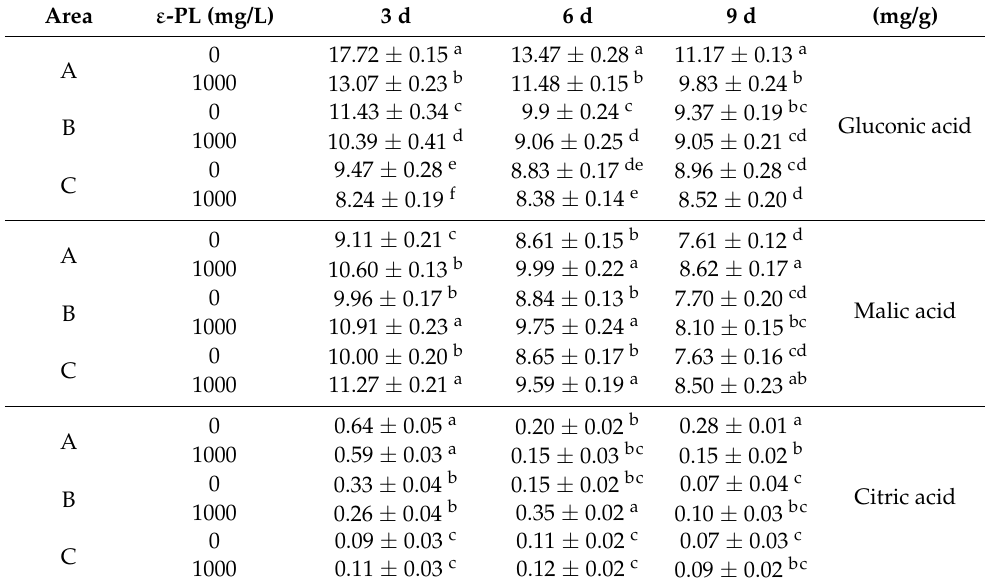
Table 1. Effects of ε -PL treatment on the secretion of organic acids in different areas of the P. expansum – apple interaction. The content of organic acids was measured on days 3, 6, and 9 of apple storage. The results represented the mean ± standard deviation of 3 repetitions of each